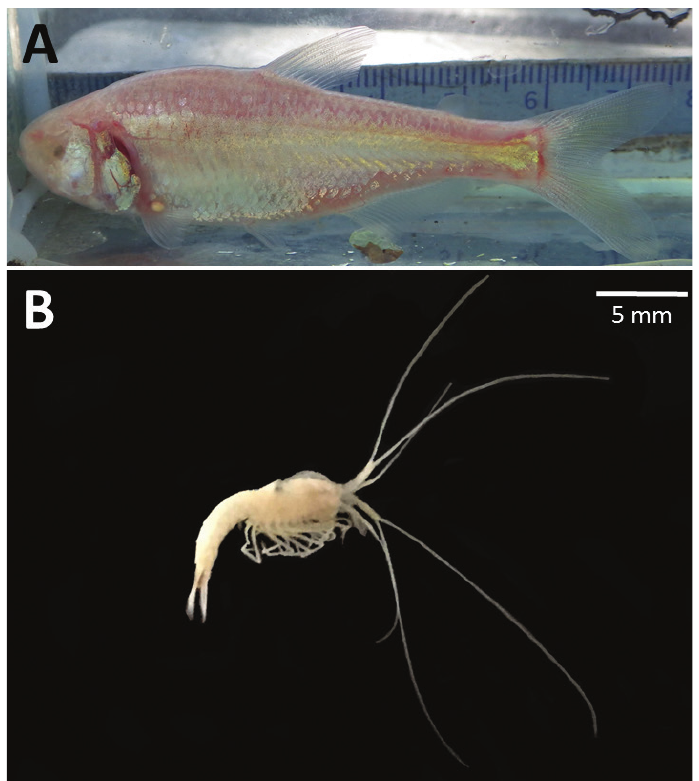
Figure 1. A Astyanax mexicanus from Chiquitita cave B The mysid shrimp, Spelaeomysis quinterensis, also from Chiquitita cave. Both stygobitic organisms have overlapping biogeographic ranges throughout the El Abra karstic area, in northeaster